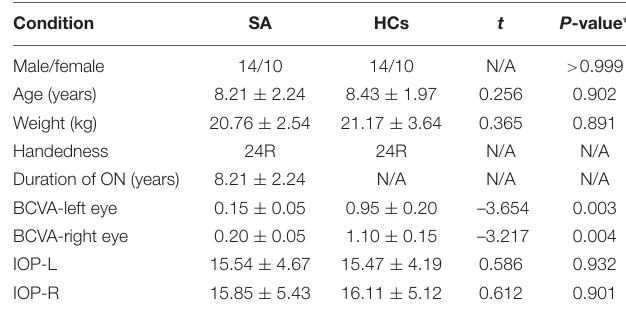
TABLE 2 | Participant